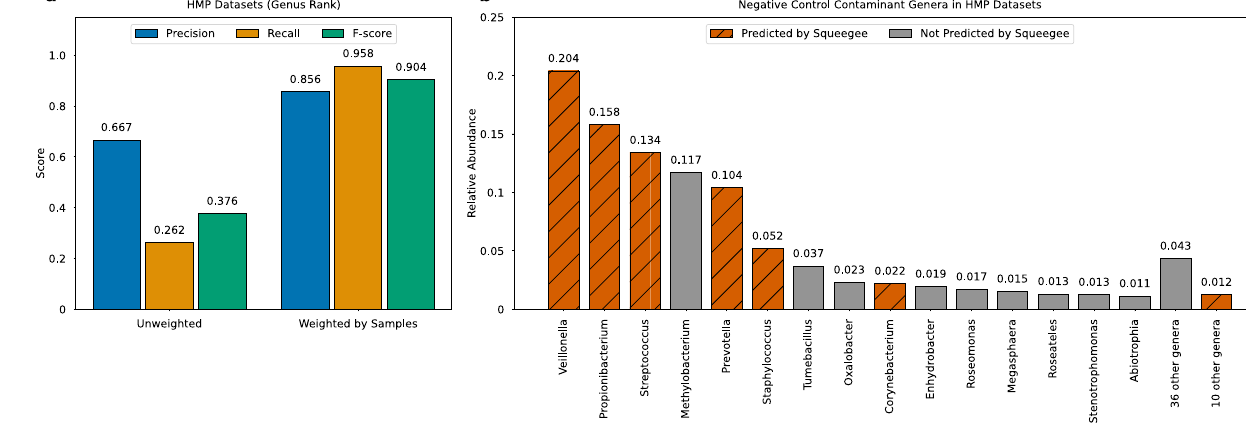
ground truth and the total number of taxa in the ground truth. While weighted by samples, the measurements are weighted by the mean proportion of the reads assigned to each taxon in the non-control experiment samples. b The right panel highlights the correctly predicted genera marked in orange with stripes, and the genera that Squeegee failed to predict are marked in gray. Genera with relative abundance below 1% are combined. Source data are provided as aSource Data fi